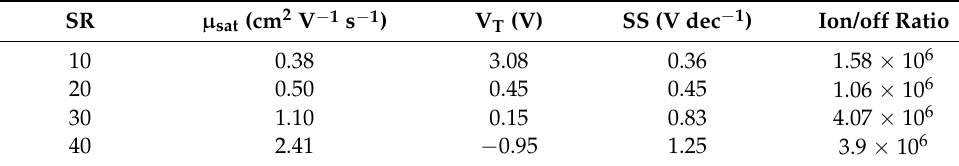
Table 1. Summary of electrical parameters of TFT specimens: